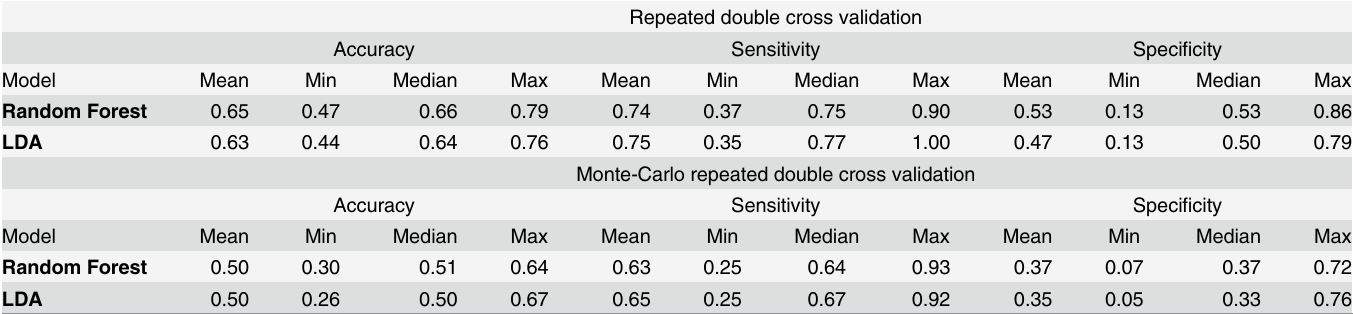
Table 6. Accuracy results of repeated double cross validation of the Random Forest and Linear Discriminant Analysis (LDA) models built to clas- sify urine samples from patients with prostate cancer and cancer-free controls based on the presence or absence of VOCs.